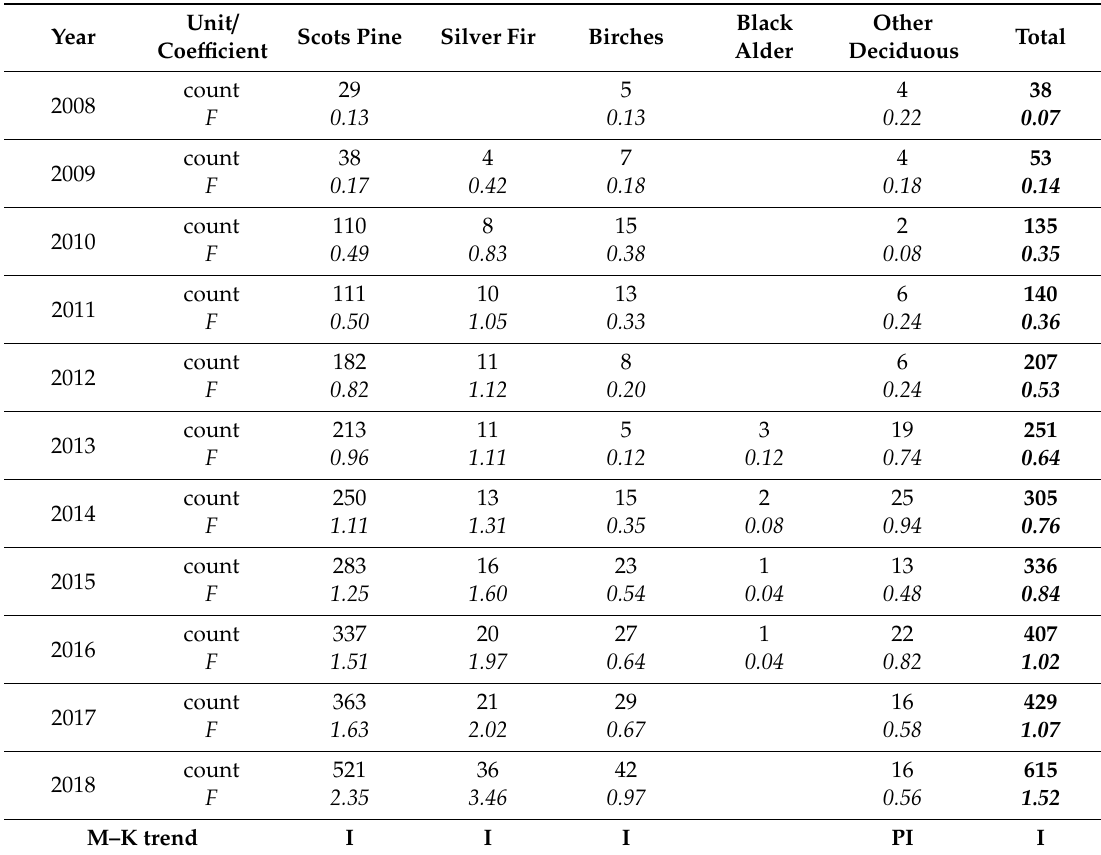
Table 1. Mistletoe occurrence on major Poland forest tree species and groups of species in forest monitoring level 1 plots in the years 2008–2018 in Poland as expressed by the absolute number of tree injuries caused by V . album , the F coe ffi cient, and the trend determined by the Mann–Kendall